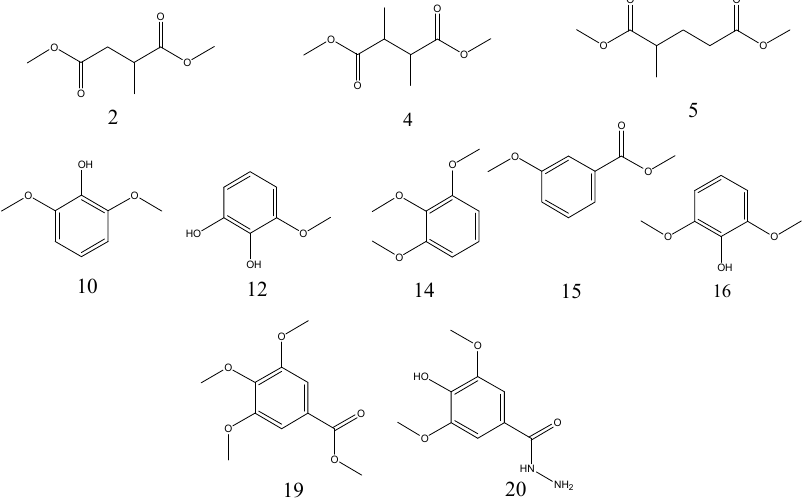
Figure 6. The chemical structures of the main pyrolytic products in TAS, GWE, and FGWE. Table 3. The relative intensities of pyrolytic products of TAS, GWE, and FGWE.